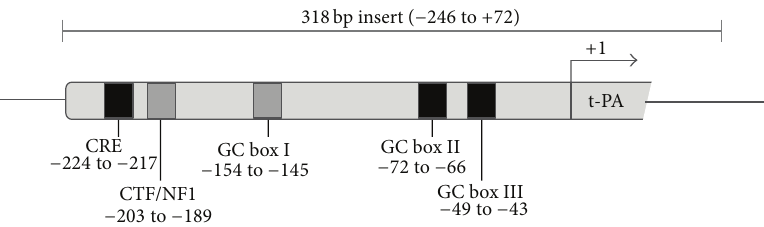
Figure 1: Schematic illustration of the proximal promoter region of the t-PA gene and the coverage of the insert used in presented reporter studies. Marked boxes illustrate previously described cis-acting elements [16, 17]; the cAMP responsive element- (CRE-) like site, the CAAT- binding transcription factor/nuclear factor-1- (CTF/NF1-) like binding site, and the three GC box elements (I, II, and III). Highlighted in black are elements that were subjected to site-directed mutagenesis and tested for involvement in induction by VPA. All positions in this study are given in relation to the major t-PA transcription initiation site (TIS, +1, positioned on chromosome 8:42,207,565) [18] and are according to the Dec. 2013 Genome Reference Consortium GRCh38 assembly obtained from the UCSC Genome Browser database